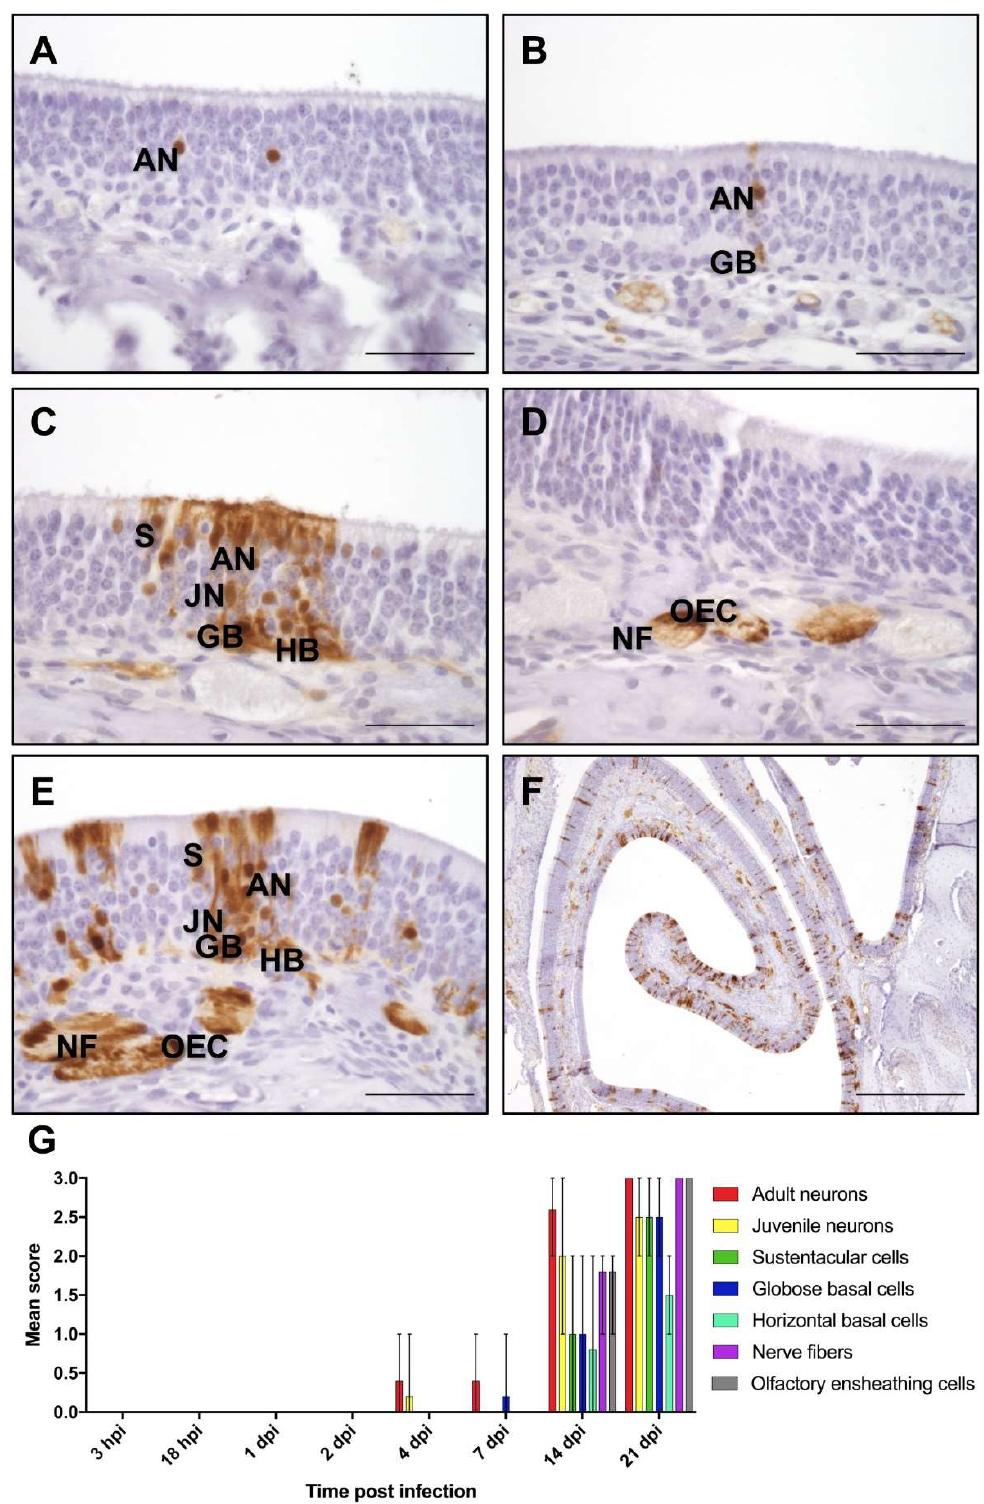
Figure 1. Immunohistological detection of Mammalian Bornavirus nucleoprotein (BoDV-1-N) in the olfactory mucosa (OM). At ( A ) 4 days post infection (dpi); ( B ) 7 dpi; ( C , D ) 14 dpi; and ( E , F ) 21 dpi. AN—adult neurons; JN—juvenile neurons; GB—globose basal cells; HB—horizontal basal cells; NF—nerve fibers; OEC—olfactory ensheathing cells. Scale bar ( A – E ): 50 µm; ( F ) 500 µm. ( G ) Mean score of immunohistochemistry: arithmetic mean; error bars: min/max; hpi—hours post infection.